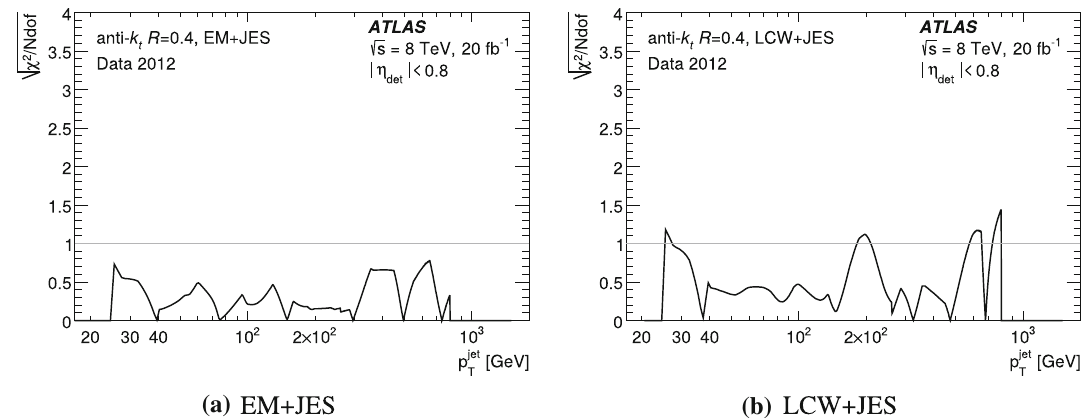
Fig. 55 The χ 2 per degree of freedom for the jet energy resolution showing the compatibility of the three in situ measurements of the jet energy resolution (dijet asymmetry, Z +jet balance, and γ +jet balance) for jets calibrated with the a EM+JES and b LCW+JES schemes